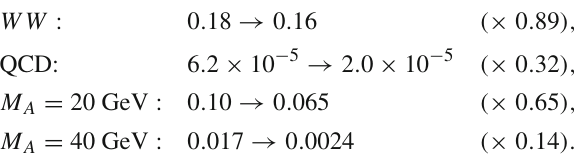
The distribution of the number of tracks N trk for the plain jets is shown in the right panel of Fig. 6. For a true diboson signal Z (cid:8) → W W , our results are close to the ones obtained by the ATLAS Collaboration, with a slightly smaller num- ber of tracks predicted by our simulation. For R → SS with M A = 20 GeV, the distribution has a maximum at the 25 − 26 bin, close to the maximum of the QCD back- ground. For M A = 40 GeV the signals have, on average, more tracks than the background itself. For the W Z selec- tion, the requirement N trk < 30 reduces the efficiency of the signals and background